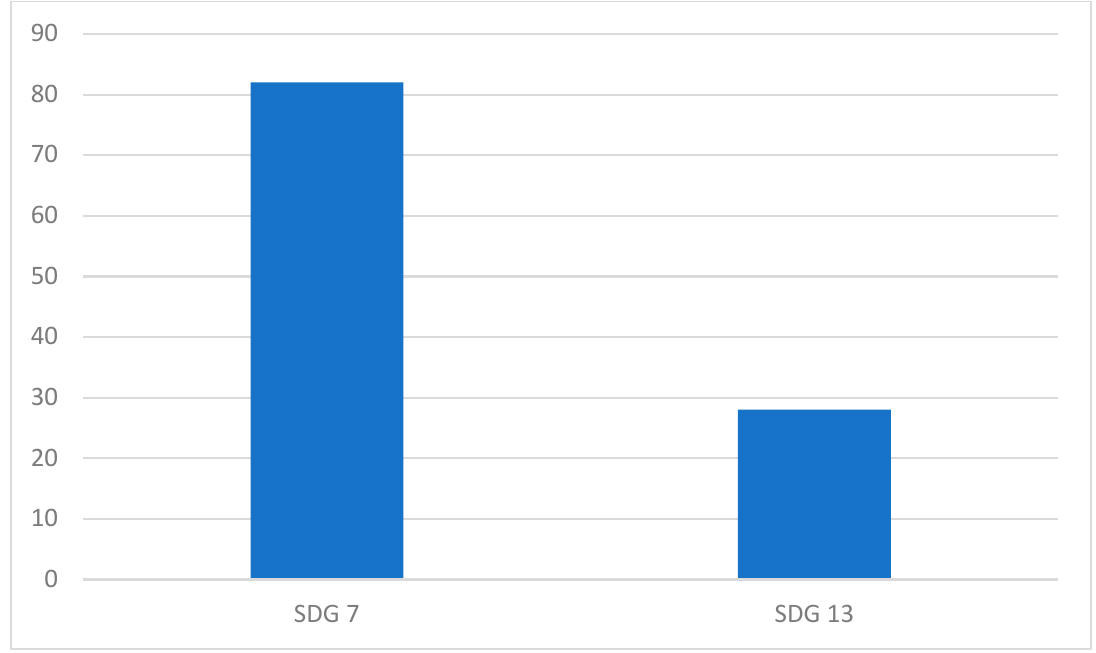
Figure 10. SDGs discussed in the records.